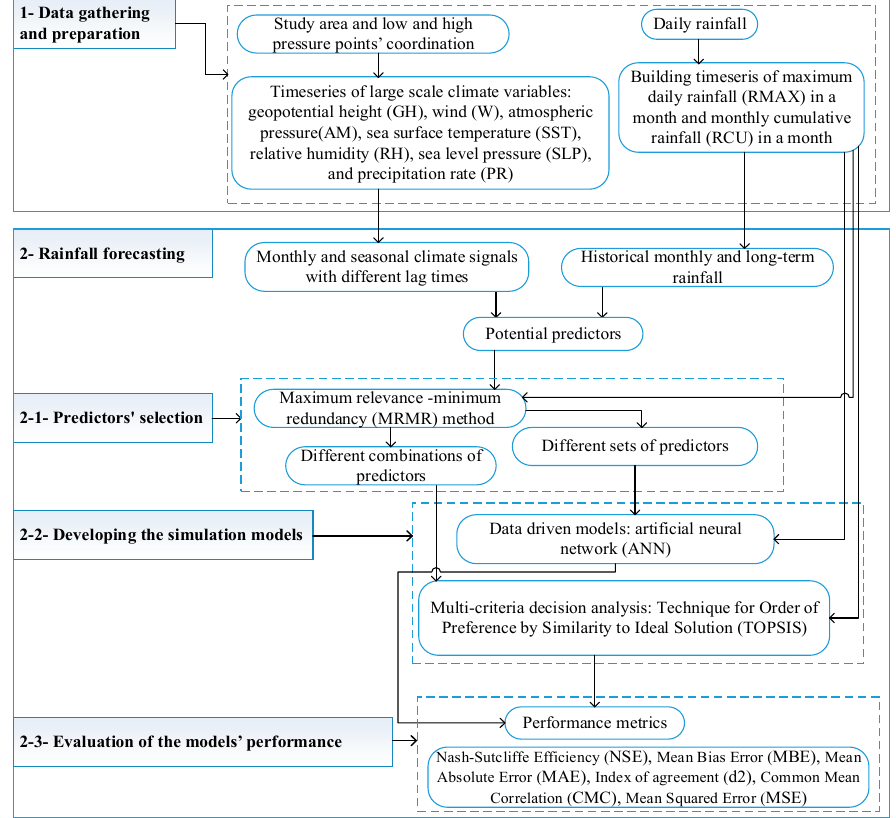
Figure 1. Proposed methodology flowchart for large scale rainfall forecasting.